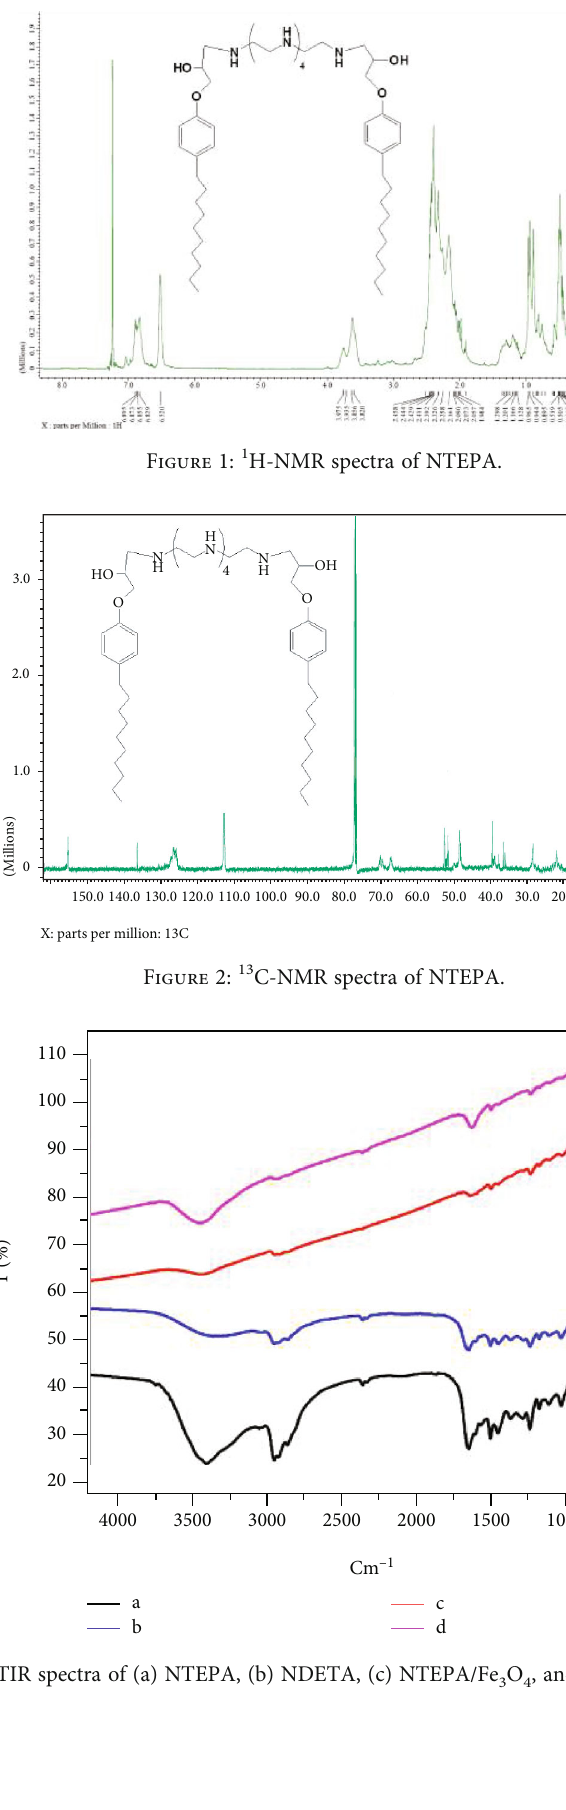
O , and (d) NDETA/Fe 3 4